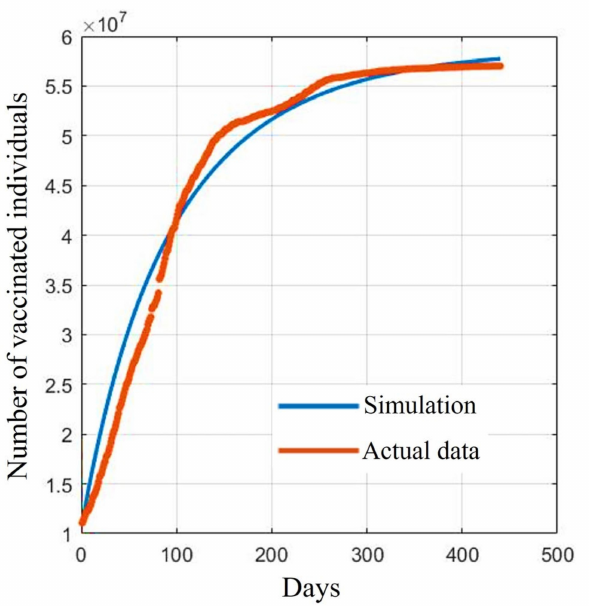
Figure 2. Comparison between the reported data and the fitted data of vaccinated